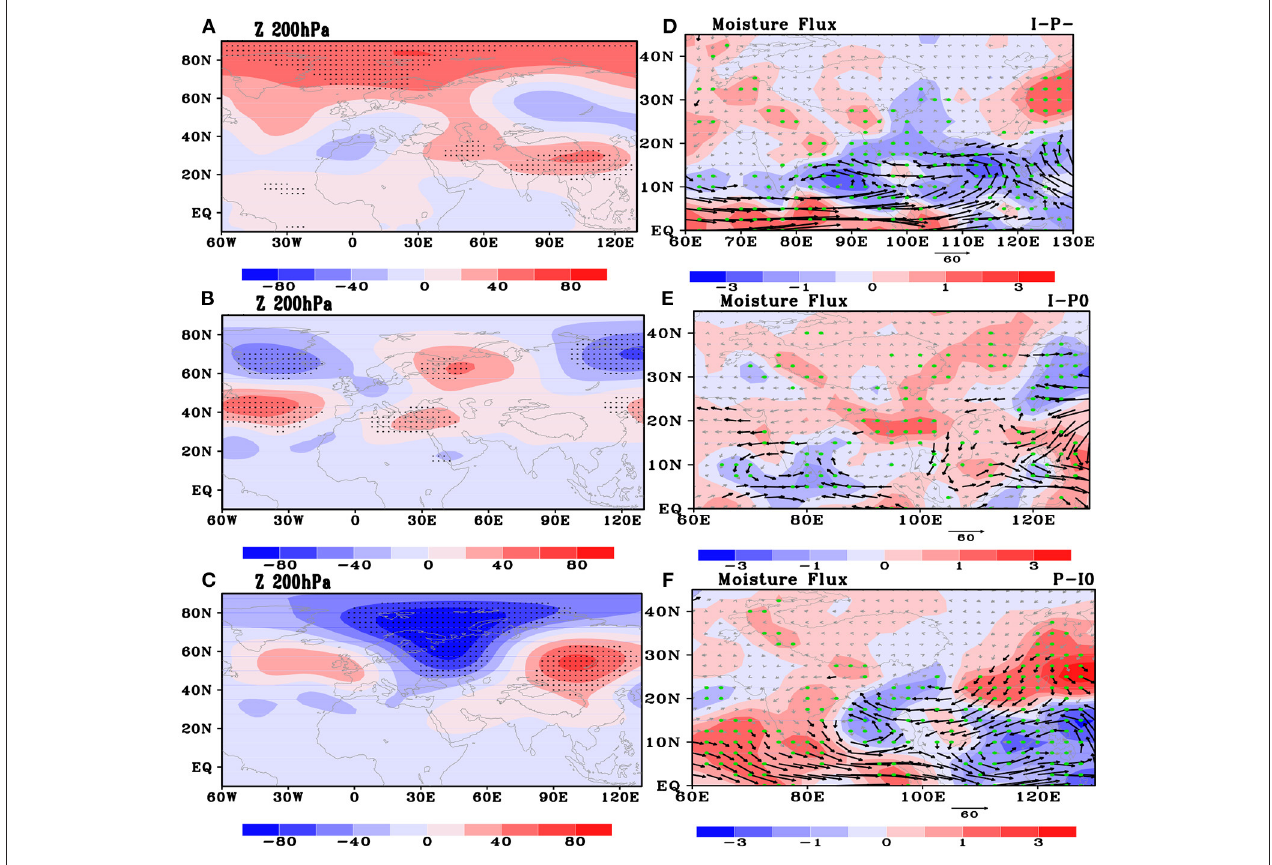
FIGURE 6 | As in Figure 5 , but for the negative phases of IOD and